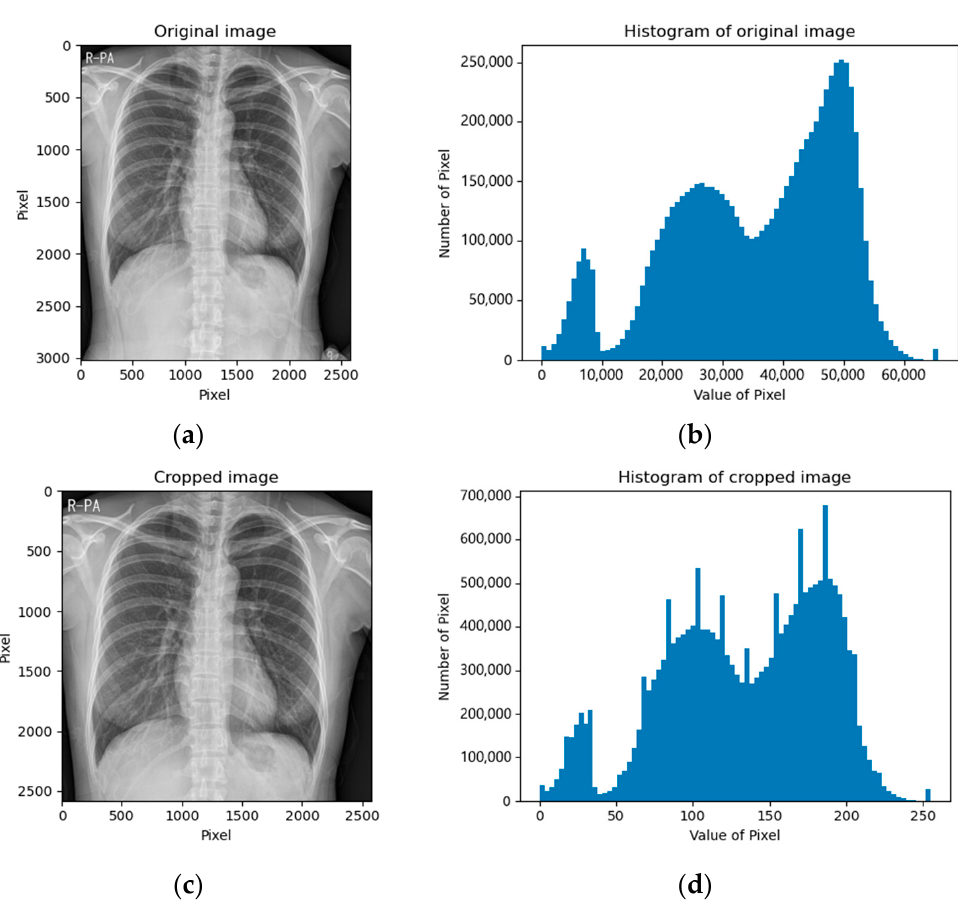
Figure 3. Cropped CXR images of the SCH data set: ( a ) original image; ( b ) histogram of original image; ( c ) bottom-cropped image; ( d ) histogram of bottom-cropped image.